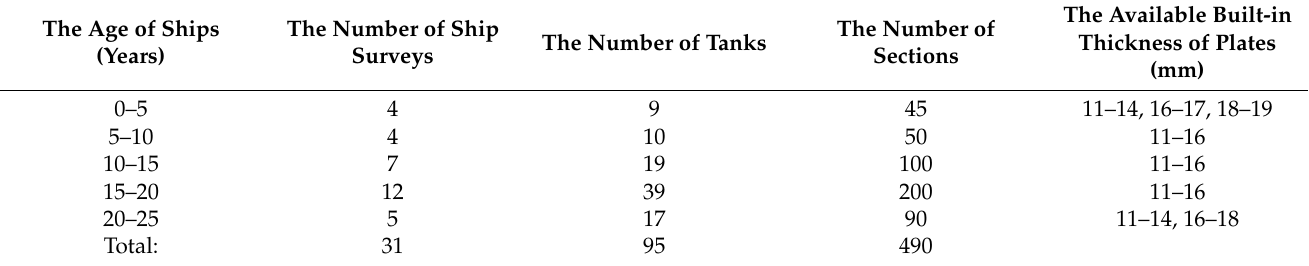
Table 3. The basic information on the database and the original thickness of the longitudinal girder